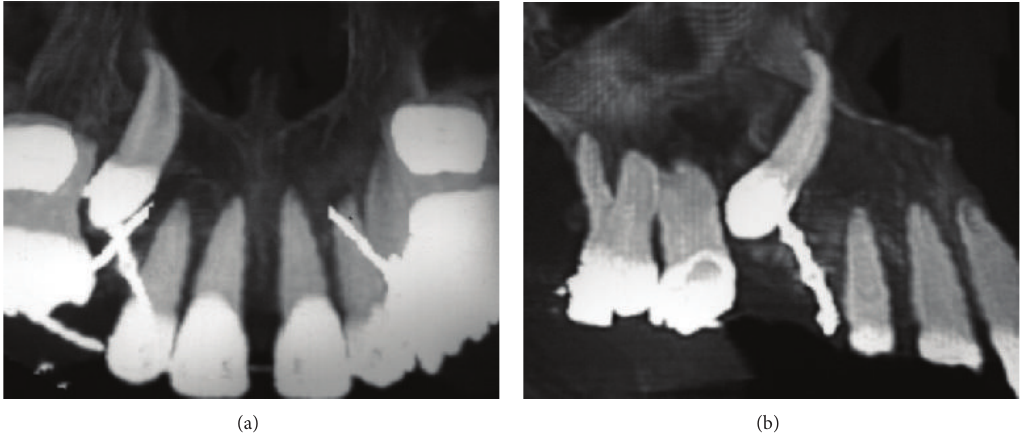
Figure 3: Right maxillary canine with large dilaceration root and orthodontic appliance for orthodontic traction.